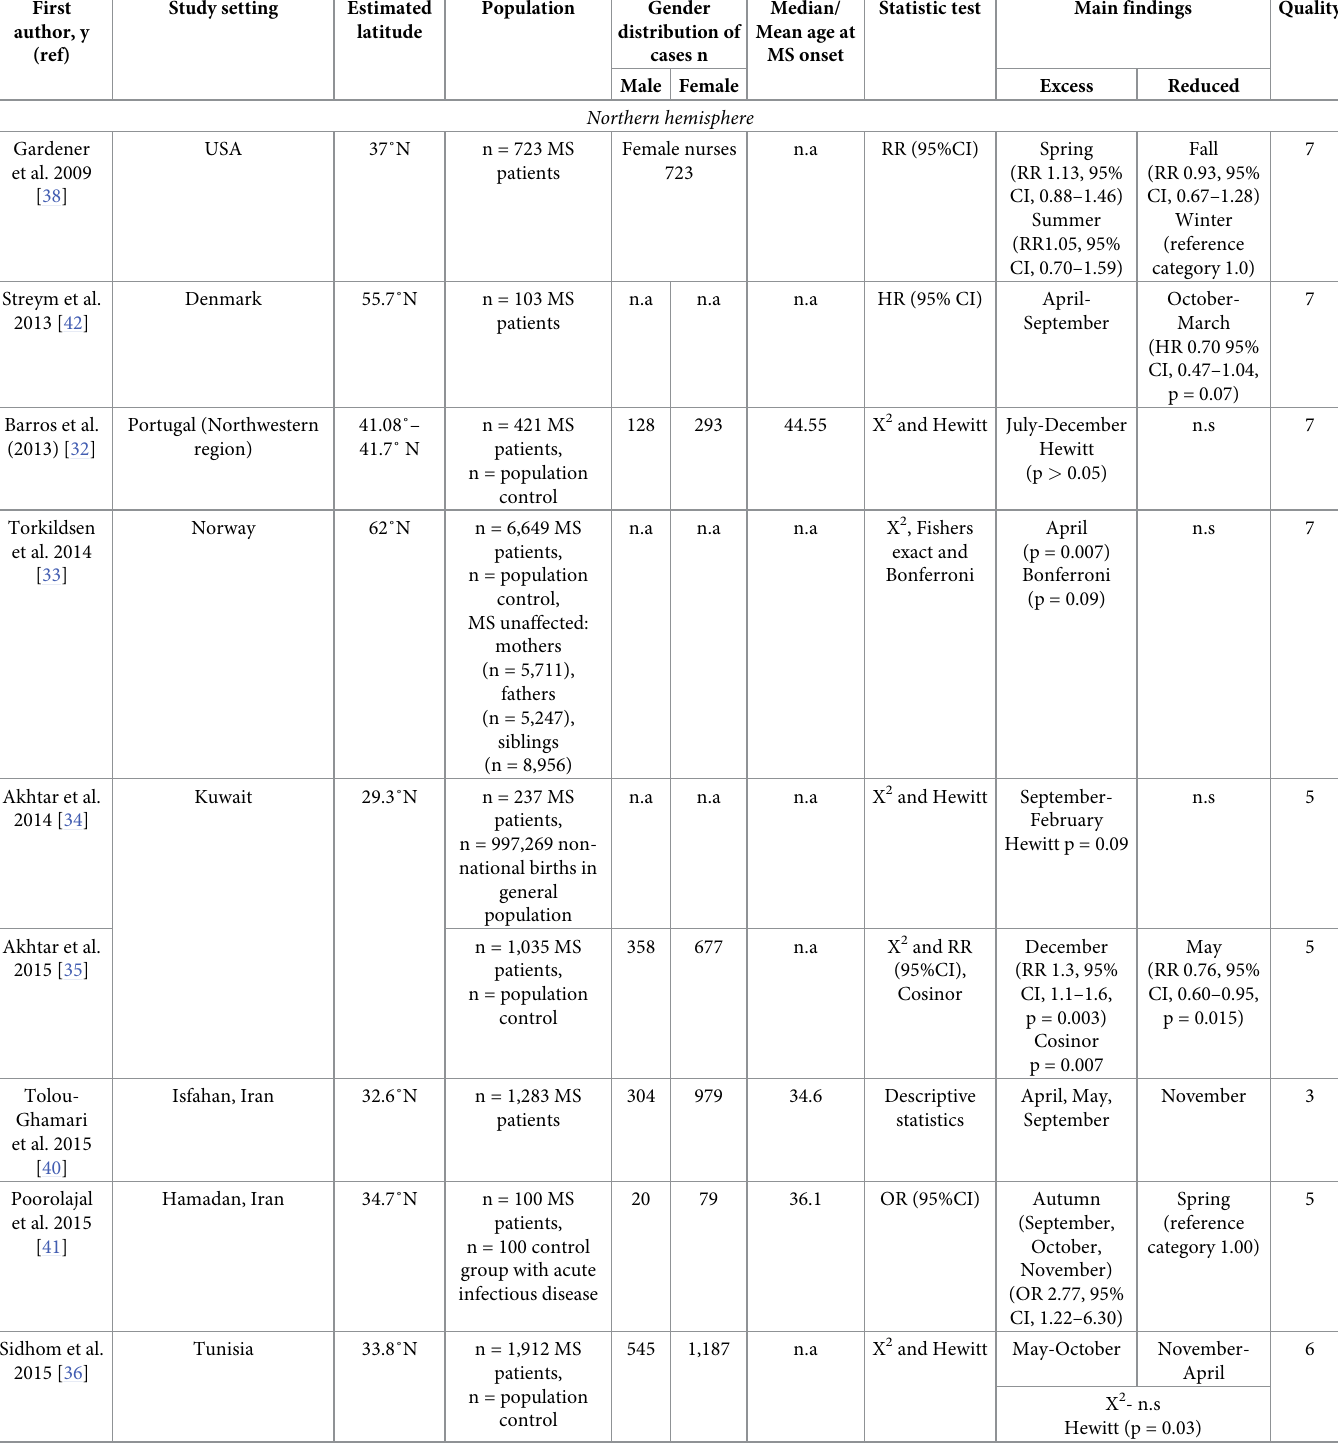
Table 3. Characteristics of studies assessing the season or month of birth as a risk factor for development of